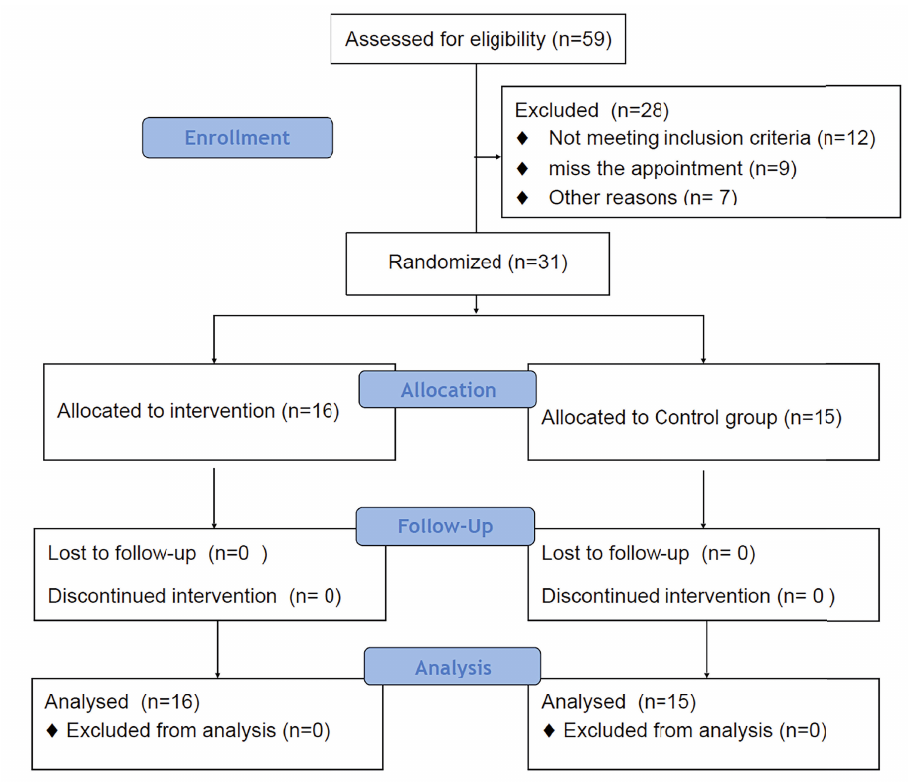
Figure 1 - Consort fl